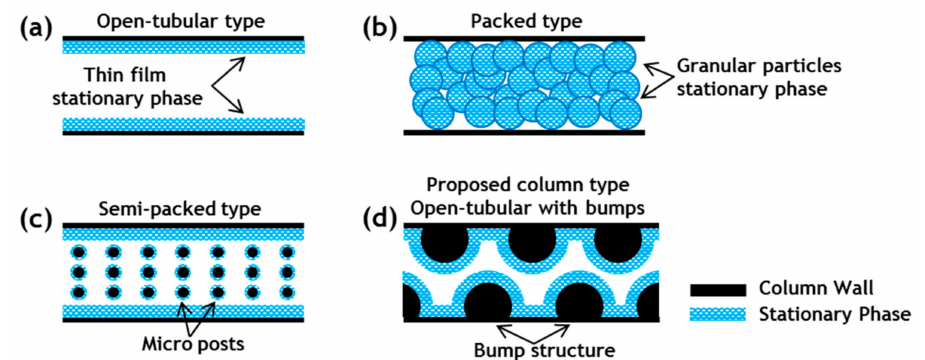
Figure 1. Various gas chromatography (GC) column types. ( a ) Open-tubular-type column with a thin-film stationary phase coated onto the inner wall of the column; ( b ) packed-type column in which the stationary phase of the small granular particles is packed inside the column; ( c ) semi-packed-type column featuring a micro-post array fabricated along the length of the column channel through a micromachining process. Typically, semi-packed columns are coated with a thin-film stationary phase; ( d ) proposed bump structure micro GC ( µ -GC) column. The proposed column is coated with a thin-film stationary phase and is mechanically robust, demonstrating high-performance gas